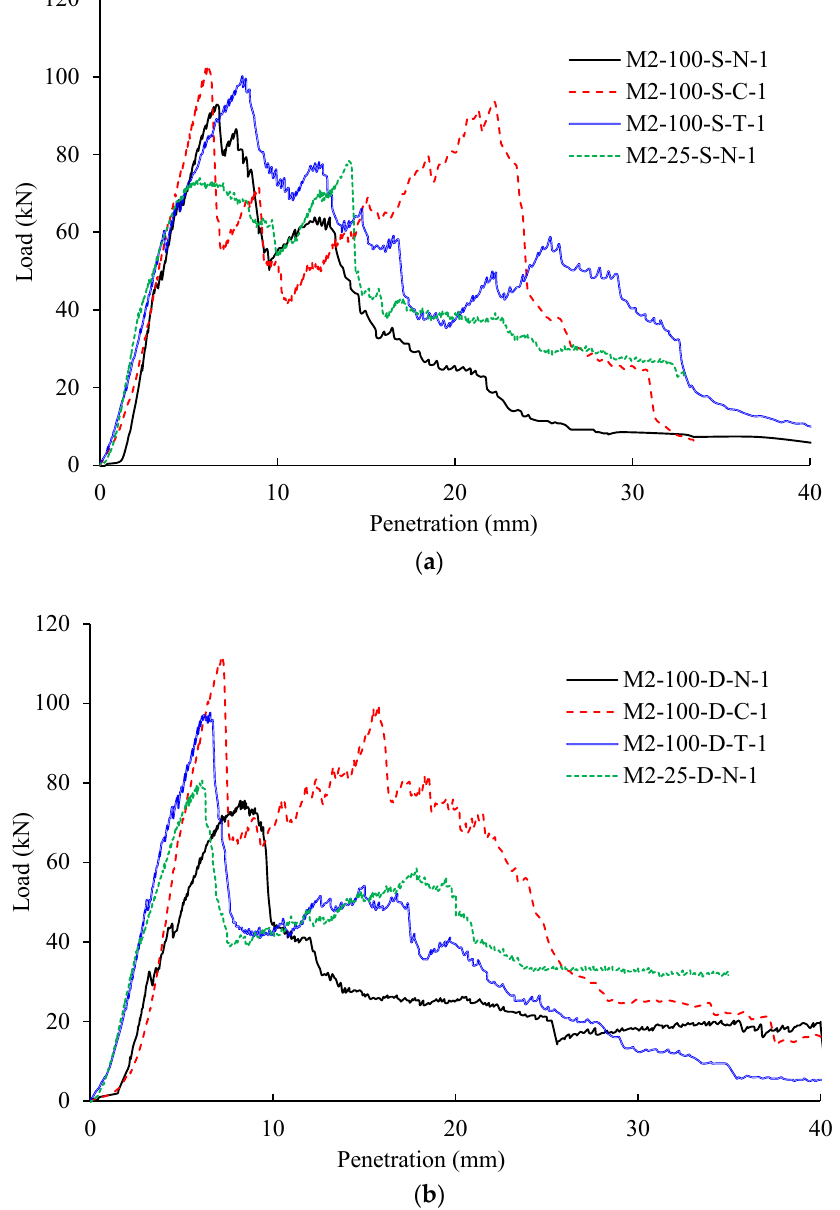
Figure 6. Load vs. projectile penetration plots for concrete slabs of mix M2: ( a ) singly reinforced; ( b ) doubly reinforced.